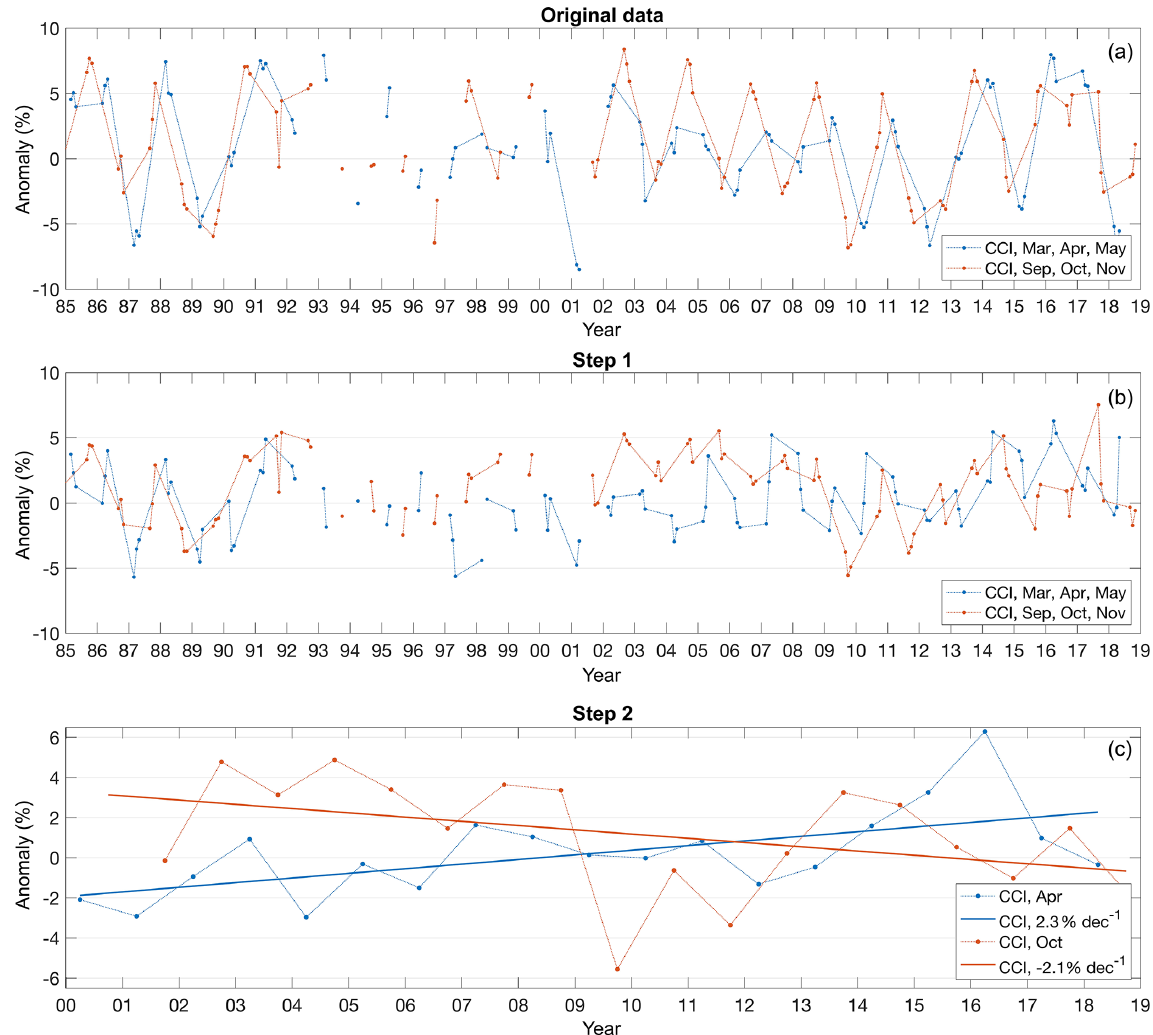
Figure 1. Two-step multiple linear regression example from CCI for 10 ◦ S–10 ◦ N and 30–35km. (a) Original ozone anomalies. (b) Anoma- lies with cycles removed. (c) Linear trends estimated for 2 selected